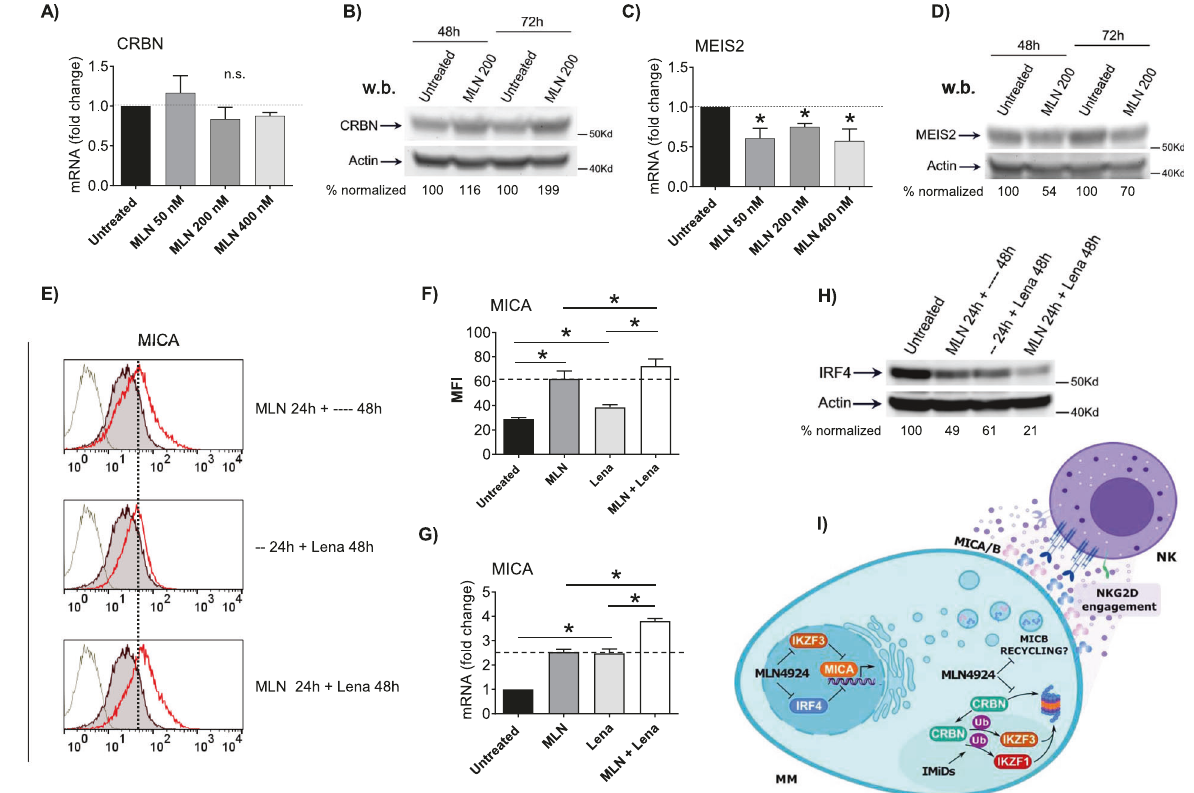
Fig. 8 Neddylation inhibition increases upregulation of MICA induced by IMiDs. A , C Real-time PCR analysis of total mRNA obtained from SKO-007(J3) cells, untreated or treated with the indicated concentrations of MLN4924 for 48 h. Data, expressed as fold change units, were normalized to GAPDH, and referred to the untreated cells considered as calibrator, represent the mean ± SEM of 3 independent experiments (* P < 0.05). B , D Western blot analysis of CRBN ( B ) and MEIS2 ( D ) in SKO-007(J3) cells untreated or treated with MLN4924 for 48/72 h. β -Actin was used as protein-loading control. Data are representative of one out of two independent experiments. Densitometric analyses of the reported Western blots are shown. E MICA cell surface expression was analyzed by fl ow cytometry on SKO-007(J3) cells treated with MLN4924 (200 nM) and/or Lenalidomide (5 µM) following the indicated scheme. ( – ) and ( — ) indicate respectively the treatment with vehicle for 24 h and 48 h. After the fi rst 24 h of MLN4924 or vehicle treatment, cells were washed twice in complete medium, reseeded, and stimulated with Lenalidomide or vehicle for additional 48 h. Representative overlays are shown. F Histograms represent the average of the mean fl uorescence intensity (MFI) values of the indicated ligand (with treatment-speci fi c isotype control MFI subtracted out). The MFI of MICA is representative of at least four independent experiments as shown in ( E ) and statistical signi fi cance was evaluated by paired Student t test (* P < 0.05). G Real- time PCR analysis of total mRNA obtained from SKO-007(J3) cells, untreated or treated as described above with MLN4924 (200 nM) and/or Lenalidomide (5 µM). Data, expressed as fold change units, were normalized to GAPDH, and referred to the untreated sample considered as calibrator, represent the mean (±SEM) of 3 experiments (* P < 0.05). H Western blot analysis of IRF4 in SKO-007(J3) cells untreated or treated with MLN4924 (200 nM) for 24 h and/or Lenalidomide (5 µM) for 48 h. β -Actin was used as protein-loading control. Data are representative of one out of two independent experiments. Densitometric analysis of the reported Western blot is shown. I Model: inhibition of neddylation and regulation of MICA/B expression on MM cells. The present study provides evidence that inhibition of neddylation increases NKG2D ligand MICA and MICB expression in MM via transcriptional and post-translational mechanisms respectively and suggests possible cooperation with IMiDs in this